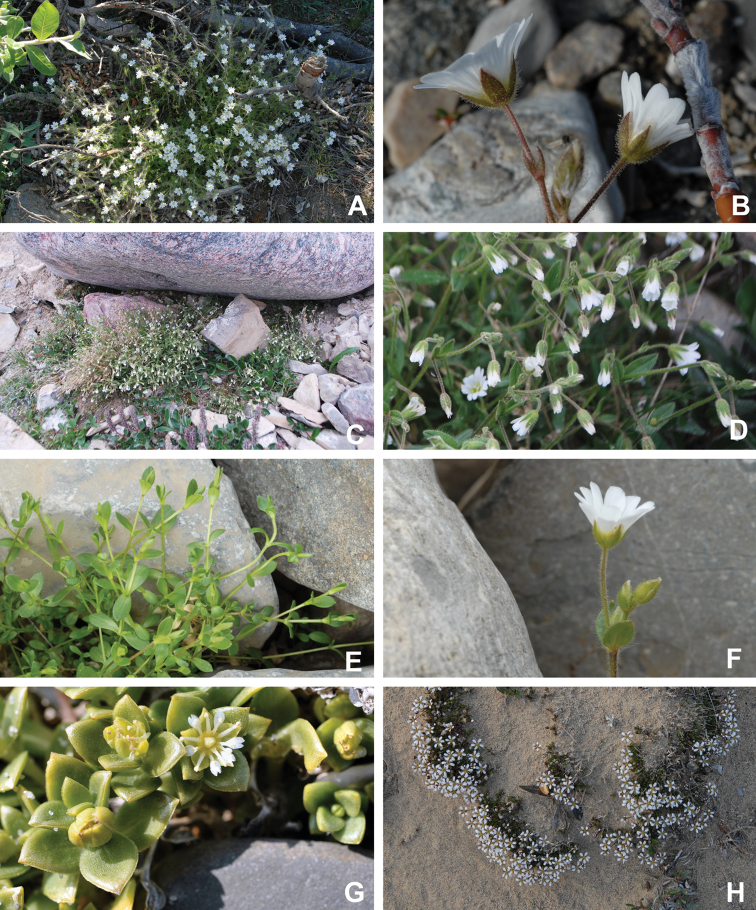
ACerastium
arcticum habit, Gillespie et al. 10164BCerastium
arcticum inflorescence, Gillespie et al. 9823CCerastium
beeringianum habit DCerastium
beeringianum inflorescence ECerastium
regelii habit, Gillespie et al. 9710FCerastium
regelii inflorescence, Gillespie et al. 9710GHonckenya
peploides
subsp.
diffusa habit and inflorescence, Gillespie et al. 9385HSabulina
rossii habit, Gillespie et al. 9385. Photos A, B, E, F, H by L.J. Gillespie C, D by B.A. Bennett and G by R.D. Bull.